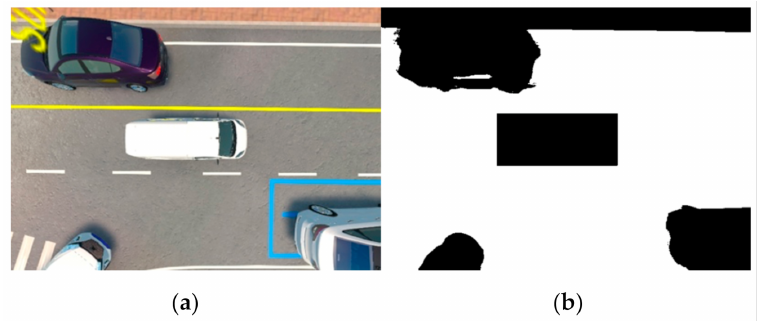
Figure 10. Result of FSD based on AVM camera tested in a simulator: ( a ) input images; ( b ) the binarized result image. The black area means non-crossable